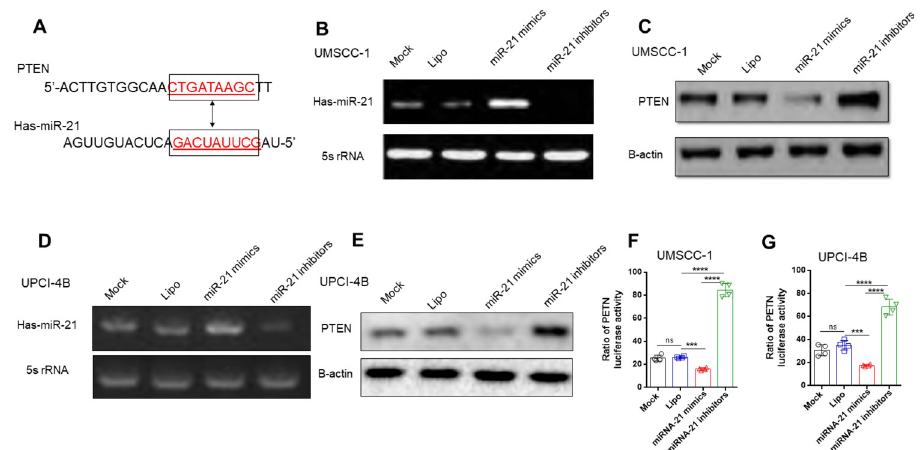
Fig 6. miR-21 can directly target the 3’-UTR of PTEN and suppress PTEN expression. (A) The binding structure of miR-21 and the 3’-UTR of PTEN. (B) RT-PCR analysis of miR-21 expression in UMSCC-1 cells transfected with the miR-21 mimic, inhibitor, or negative controls. (C) and (E) Western blot analysis of PTEN expression in UMSCC-1 and UPCI-4B cells, respectively, transfected with the miR-21 mimic, inhibitor, or negative controls showed that miR- 21 significantly inhibited PTEN expression in both cell lines. (D) RT-PCR analysis of miR-21 expression in the UPCI- 4B cell line. (F) and (G) UMSCC-1 and UPCI-4B cells were transfected with the miR-21 mimic, inhibitor, or negative controls; luciferase reporter assays showed that the miR-21 mimic significantly inhibited PTEN expression, while the inhibitor had the opposite effect. ��� , P < 0.001; ���� , P < 0.0001. ns, nonsignificant.